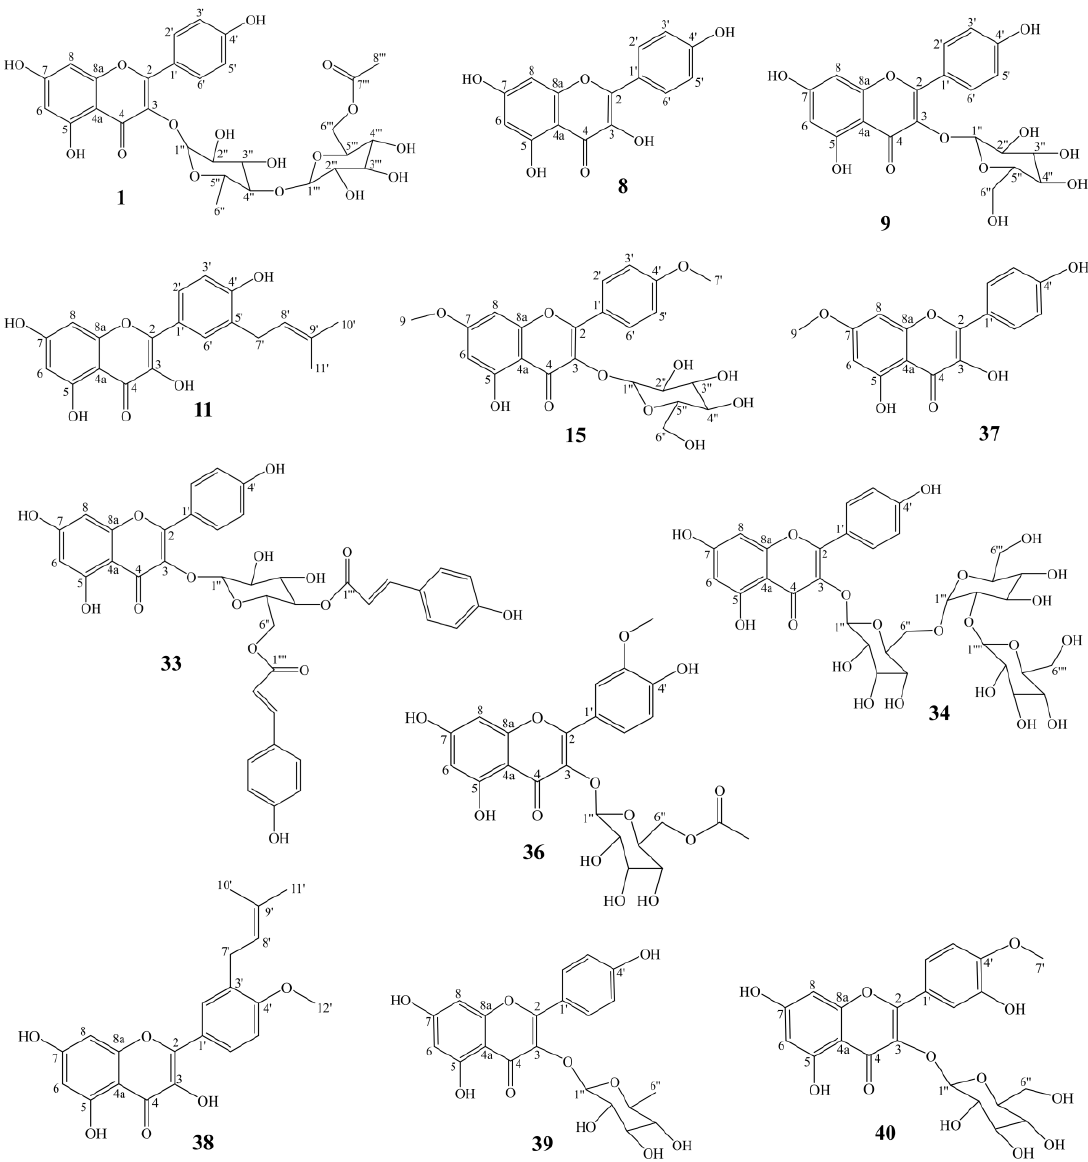
Figure 2. The structures of twelve flavonoids from A. tenuissimum flower.